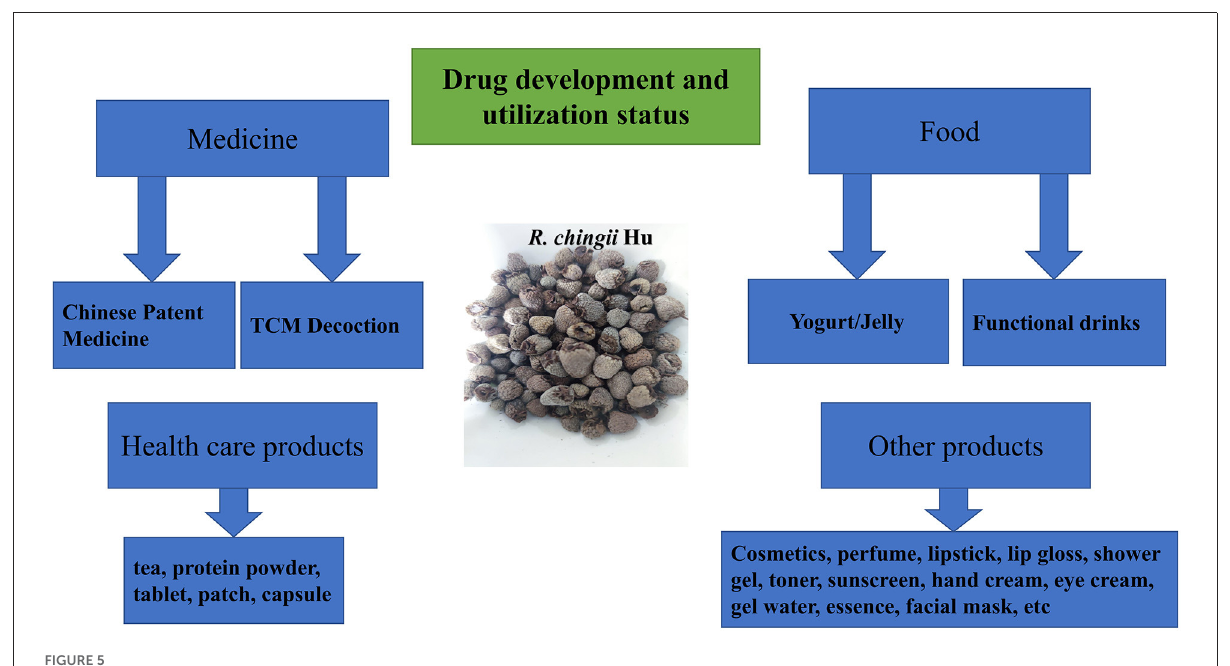
FIGURE5 Drug development and utilization status of R.chingii Hu.